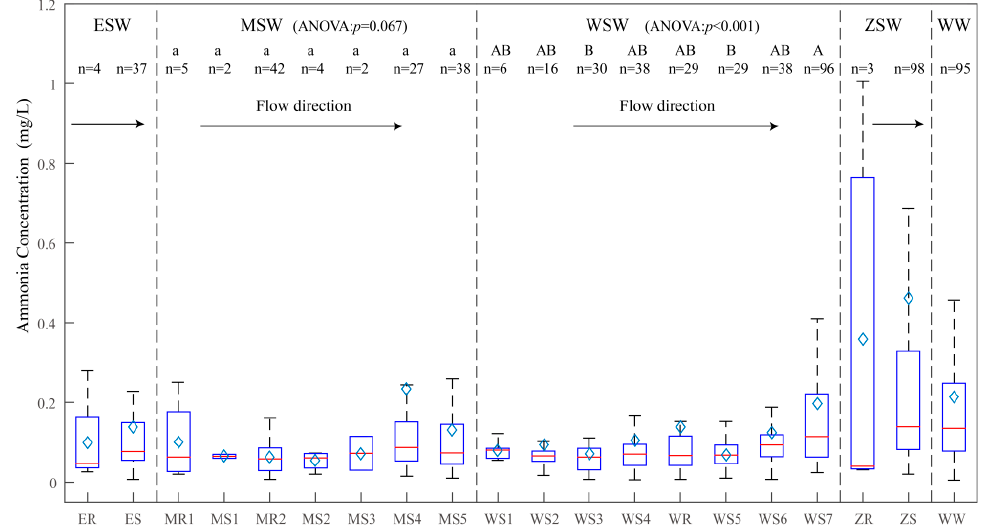
Figure 3. NH 4 ⁺‐ N concentration of surface water in different sampling sites and results of one ‐ way ANOVA. Figure 3. NH 4+ -N concentration of surface water in different sampling sites and results of one-way